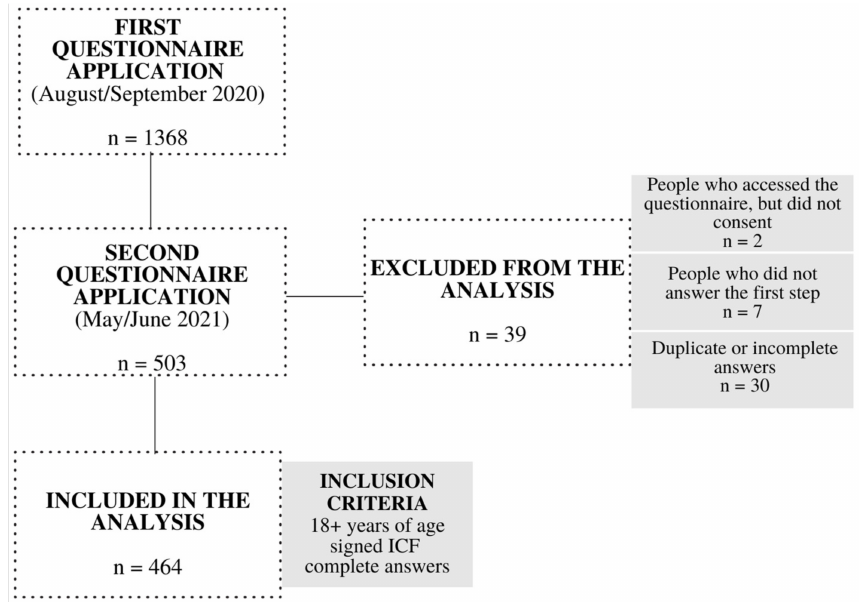
Figure 1. Recruitment of the research volunteers.